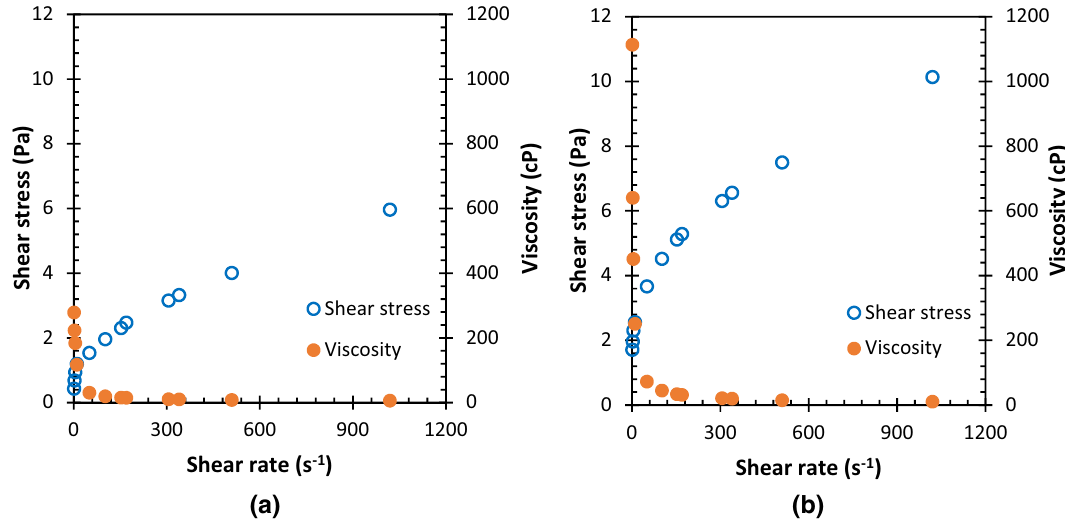
Fig. 3 Shear stress and viscosity flow curves of a XG 1000 ppm and b XG 2500